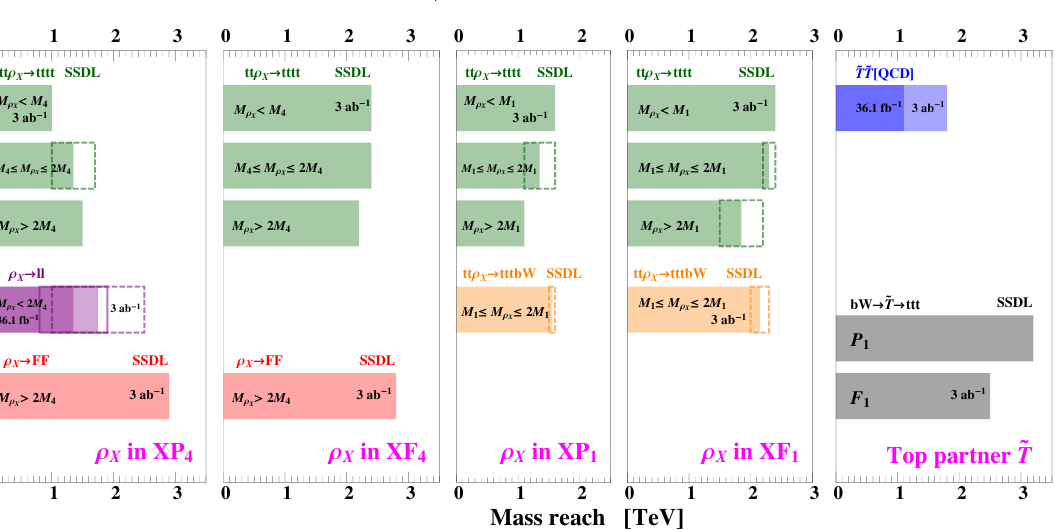
Figure 12. Summary of the present limits and prospective reach on the mass scales in models LF 4 and RF 4 for the benchmark parameters in eq. (3.1) and eq. (3.2). The bounds in models with partially composite t R are similar and not shown here except that for the single production of X we have shown the bounds in both P 4 and F 4 scenarios. The bounds on M (cid:26) are shown in three kinematical region ( M (cid:26) < M 4 , M 4 < M (cid:26) < 2 M 4 , M (cid:26) > 2 M 4 ). The rectangles for the existing searches (cid:26) L ! V V , (cid:26) R ! WW indicate the ranges of the bound when varying the parameter M 4 .